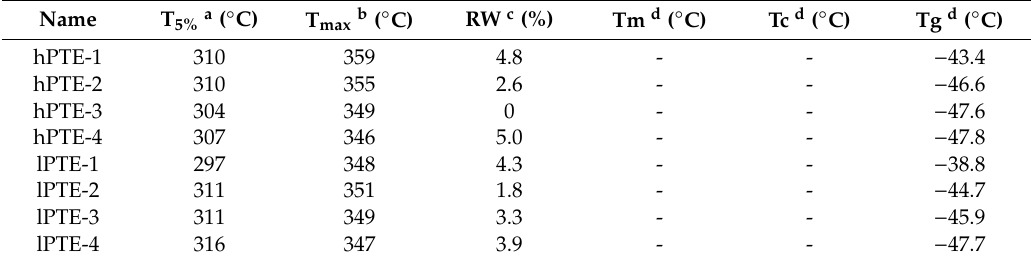
Figure 4. TGA curves ( A ) and derivative curves ( B ) of hPTE and lPTE copolymers at a heating rate of 10 ◦ C min − 1 . Table 2. Thermal characterization of hyperbranched poly( β -thioether ester)s.